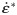
Contribution of the cell wall biophysical factors in Ectocarpus and pollen-tube tip growth.(A) For each cell type, the global stress σe was computed using measured values of turgor, curvature, and cell wall thickness (equation S2 in S1 Text). Knowing normal velocity Vn at each point, the expected strain rate ε˙* was computed according to equation S10 in S1 Text. Note the different scales between Ectocarpus and the pollen tube. (B) Relationship between stress and expected strain rate in Ectocarpus apical cells (left) and in the tobacco pollen tube (right): instead of plotting each value against s, these values were plotted against each other to show how the stress results in strain. In Ectocarpus, but not in the pollen tube, ε˙* behaves according to the Lockhart equation ε˙=Φ(σe-σy)ifσe>σy;ε˙=0 otherwise, with constant values for Φ and σy (compare with Fig 3B). (C) Robustness of this result was tested using a bootstrap analysis with 3,000 replicates. For each sample, the linearity of the part of the curve (where σe > σy) was estimated by linear regression. The distribution of the values of r2 shows that linearity is well supported (see also S4 Fig). Data are available as S4 Data. (D) Relationship between the three biophysical features of the cell wall: plastic yield threshold (σy, x-axis), thickness (δ, y-axis), and plastic extensibility (Φ, z-axis). In Ectocarpus, only variation of δ accounts for tip growth (brown line), whereas in pollen tubes, both σy and Φ vary while the wall thickness remains constant (green line).